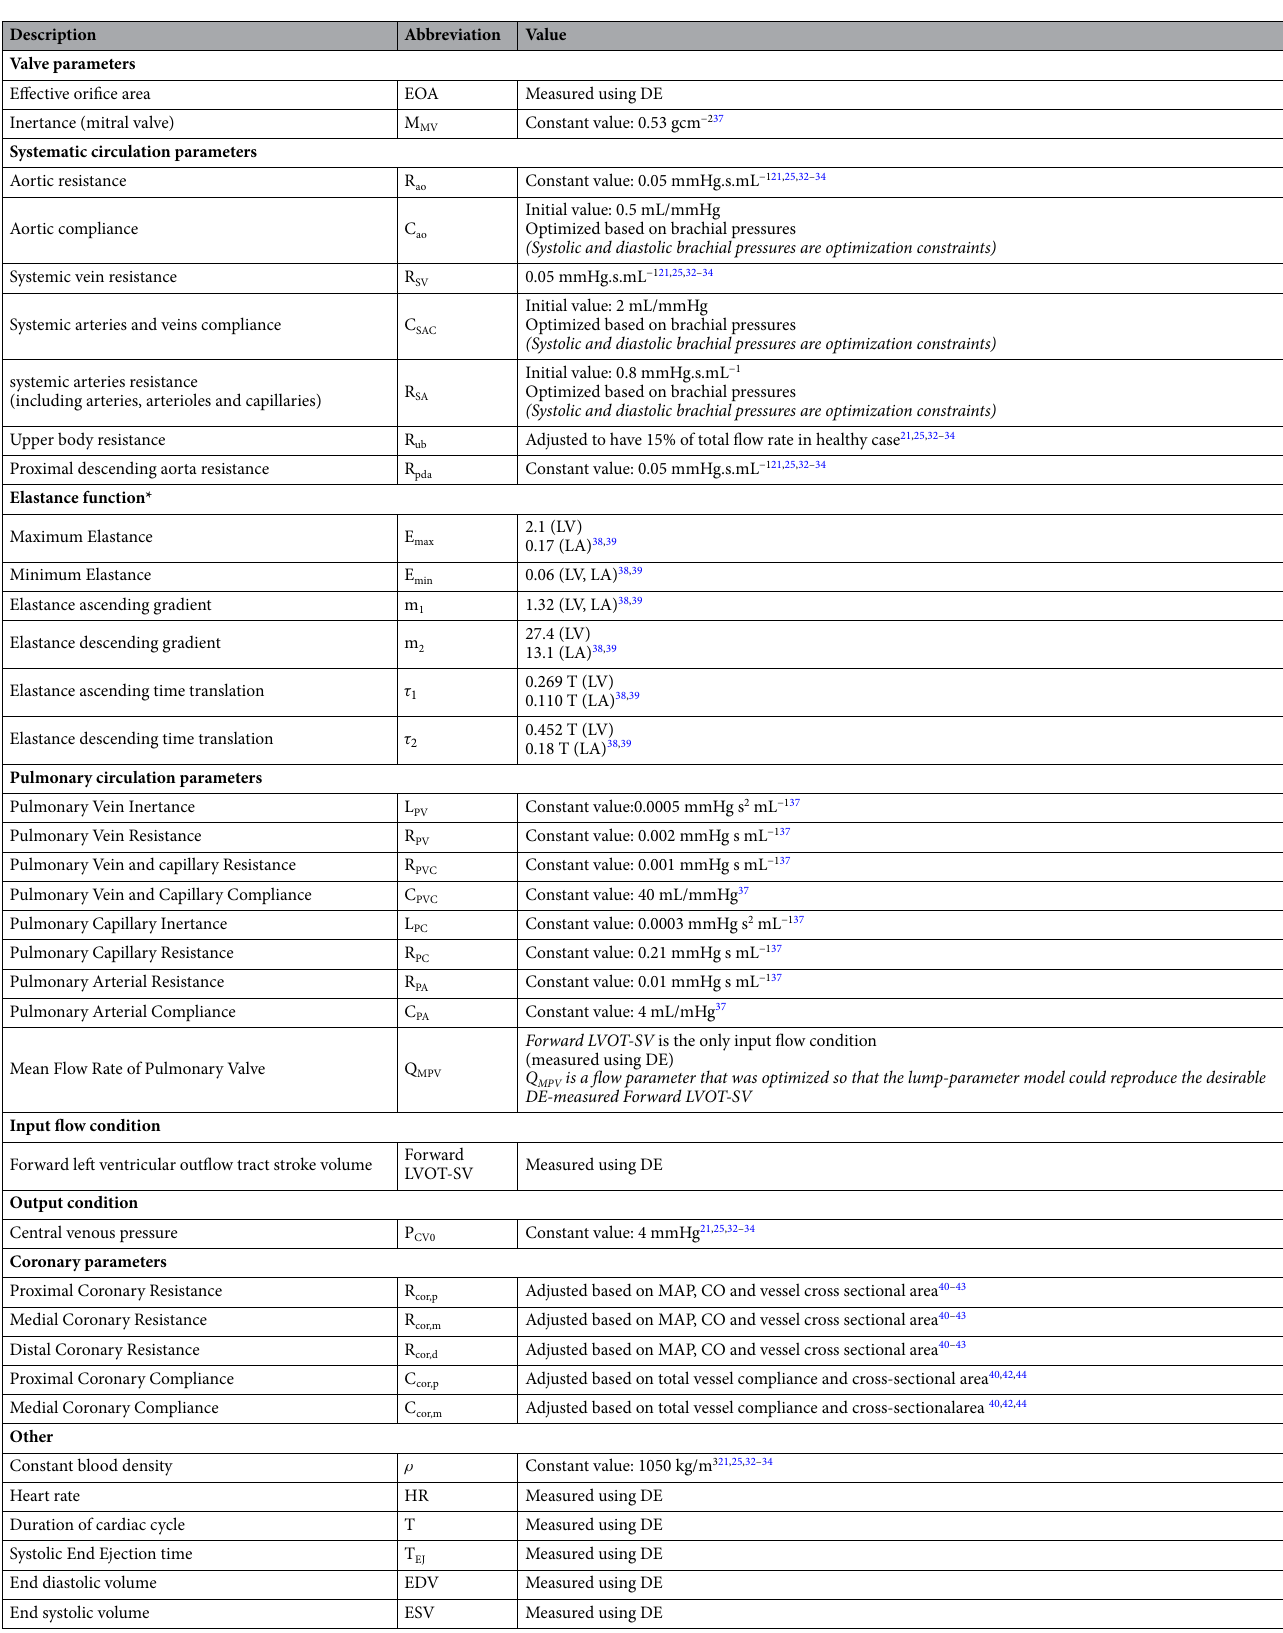
Table 2. The Cardiovascular parameters used in the lumped parameter